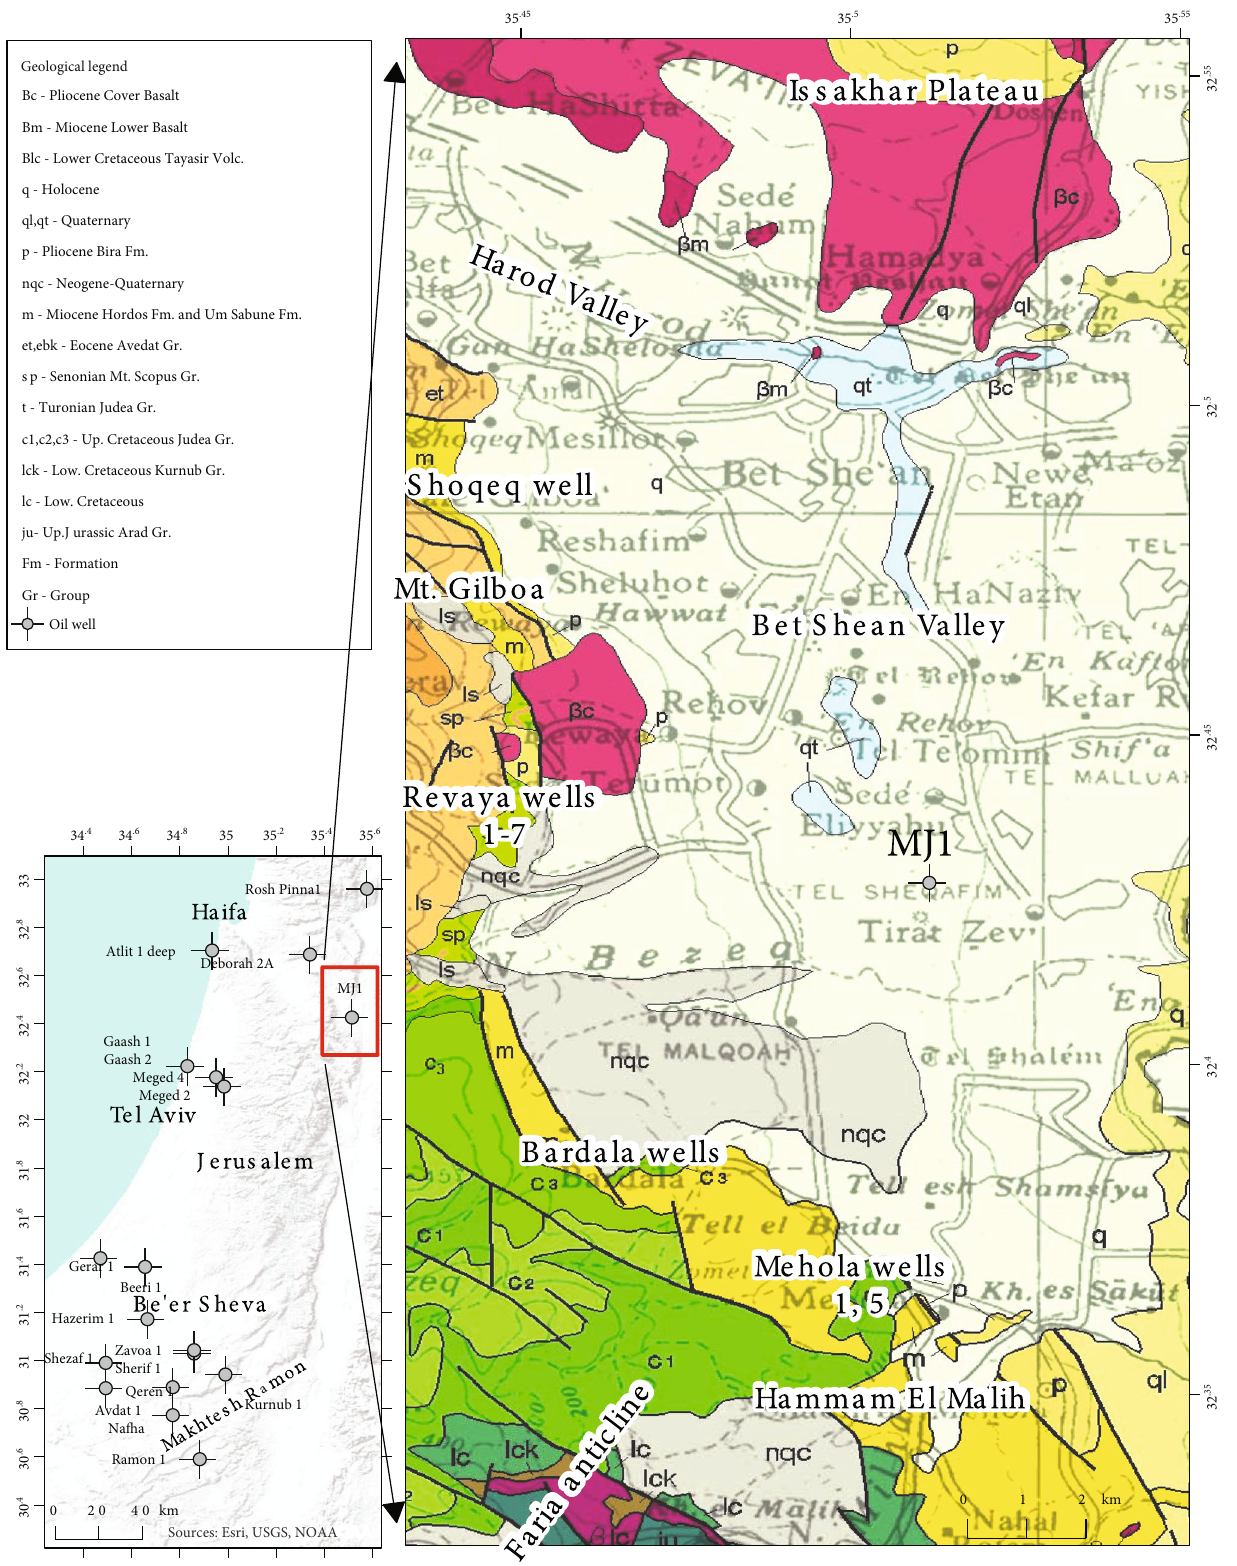
Figure 1: Geological location map. Geological data after